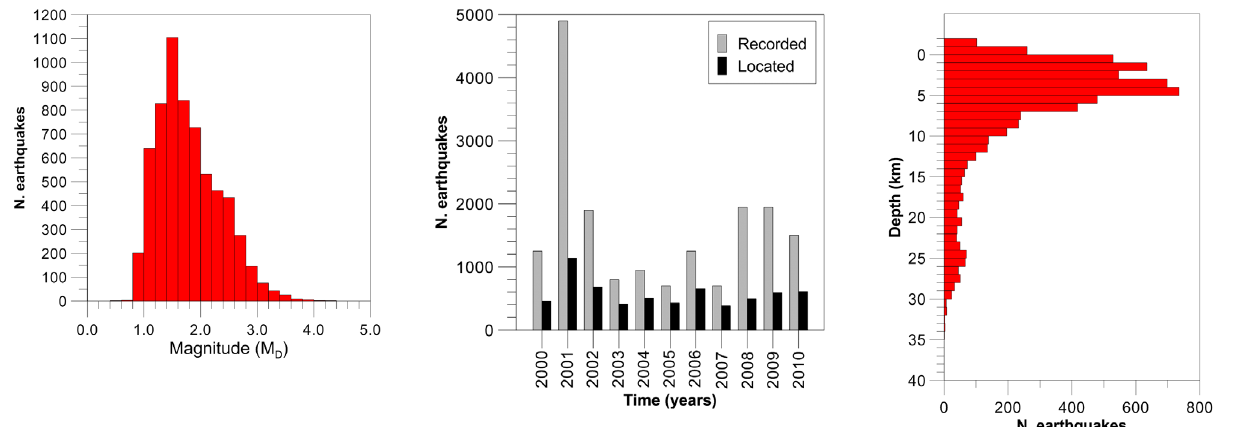
Figure 6 (left). Earthquakes number versus duration magnitude. Note the peak around the value 1.5. Figure 7 (center). In gray the number of earthquakes recorded by the seismic network in the time span 2000-2010. In black the number of localized events. Figure 8 (right). Fre- quency distribution of earthquakes with respect to depth.